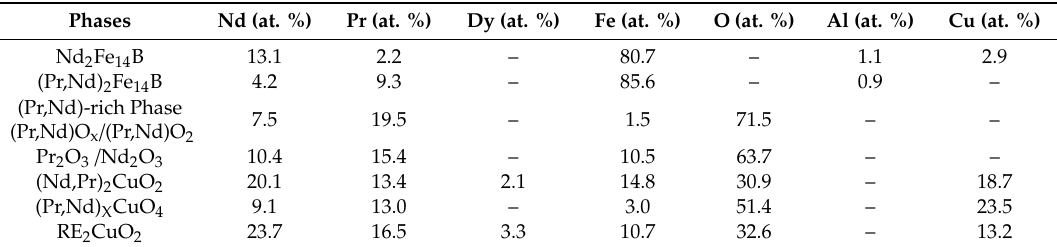
Table 2. FEG-SEM EDXS quantification of di ff erent phases in the 2 wt. % Pr-Cu GBD processed recycled HDDR Nd-Fe-B bulk